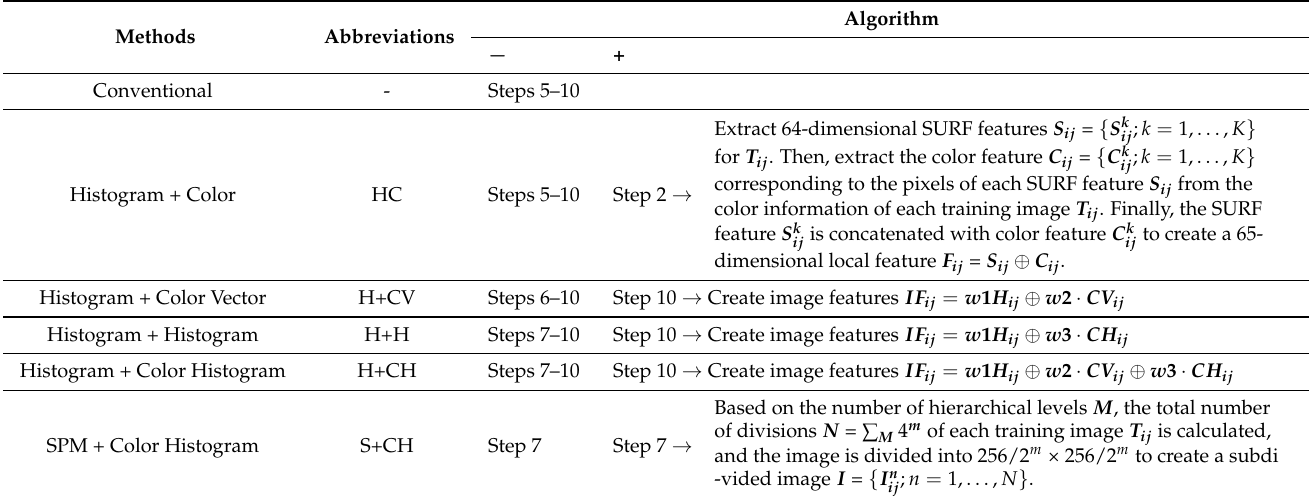
Table 1. Abbreviations of comparison methods and algorithmic differences between the comparison methods and the proposed method.